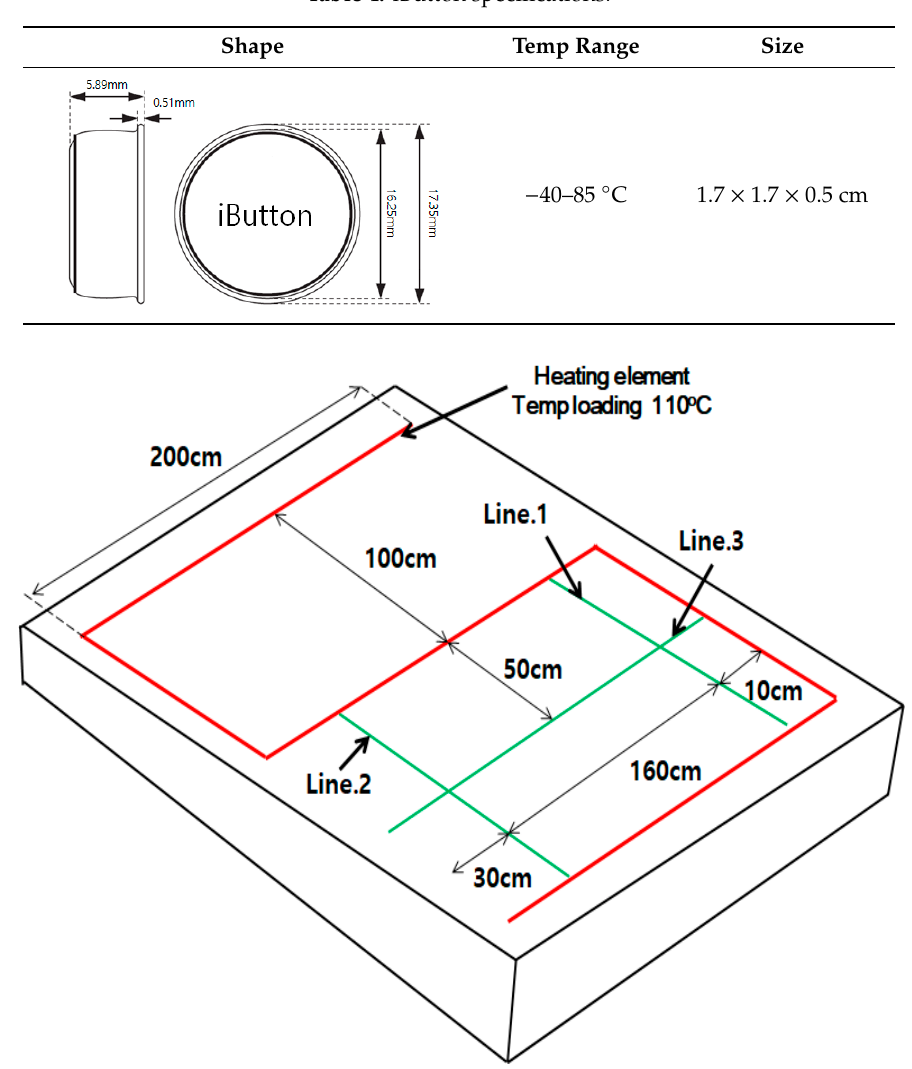
Table 4. iButton specifications.